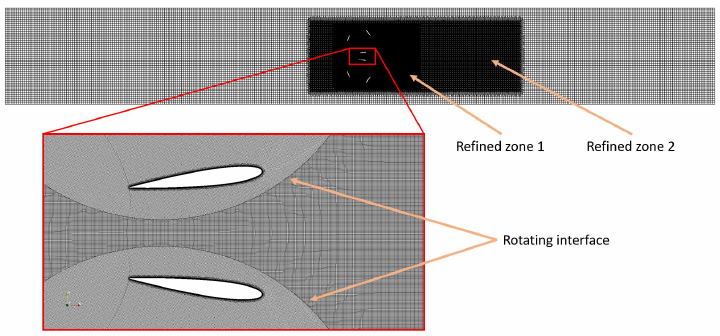
Figure 17. An illustration of the forward counter-rotating mesh.